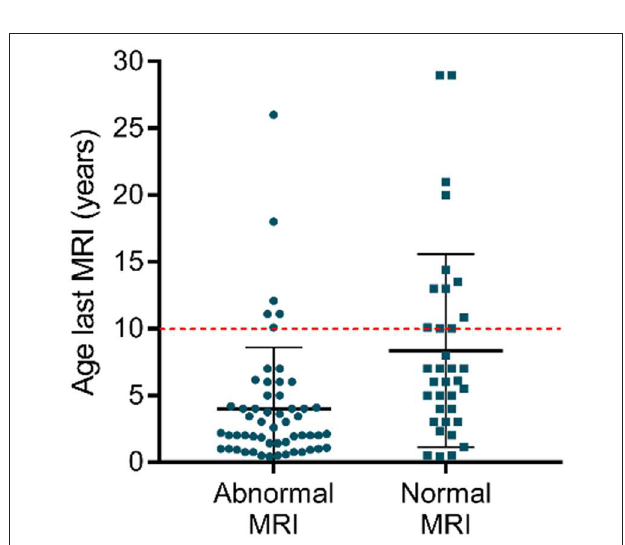
FIGURE 2 | Myelin appearance (abnormal MRI vs. normal MRI) in AHDS patients in function of the age at the last MRI. Each point represents one patient, and the scatter plots also depict mean ± standard deviation. Finding normal WM status on MRI is more likely in older patients. Notice that above the age of 10 (red dotted line), there are still several patients with an abnormal WM status as observed on MRI. The references for the patient reports used for this graph can be found in Table 1 . This graph was made using GraphPad Prism v7.00.